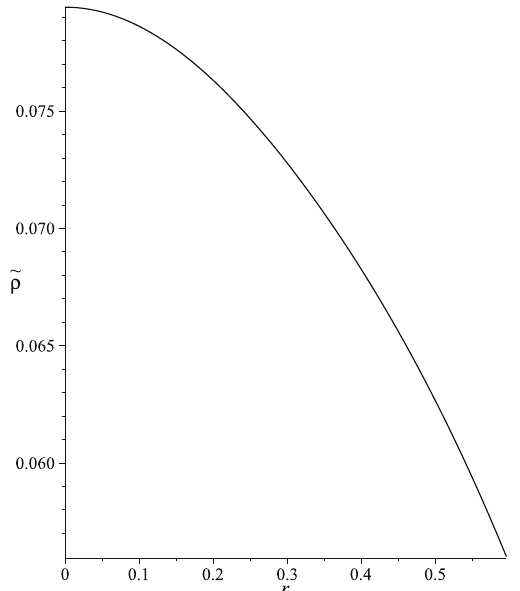
Fig. 8 Energy density for the solution obtained with the first algorithm with F (cid:9)= 0 from the isotropic Gold III